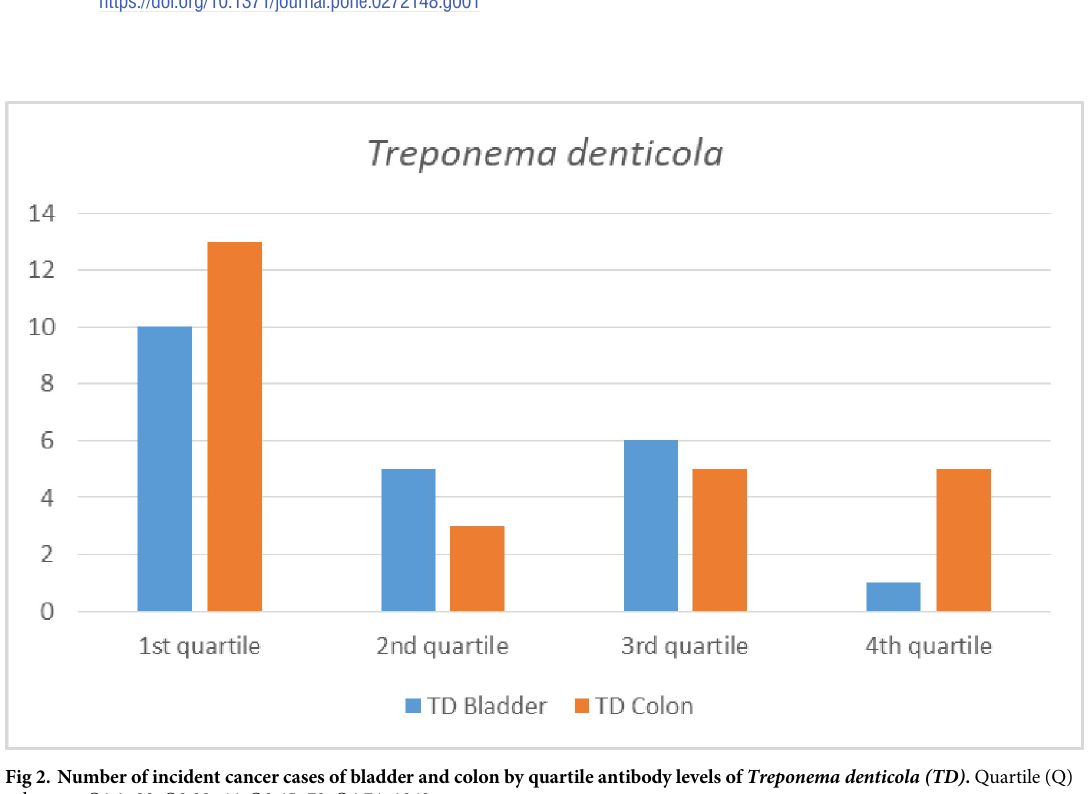
PLOS ONE | https://doi.org/10.1371/journal.pone.0272148 August 22,